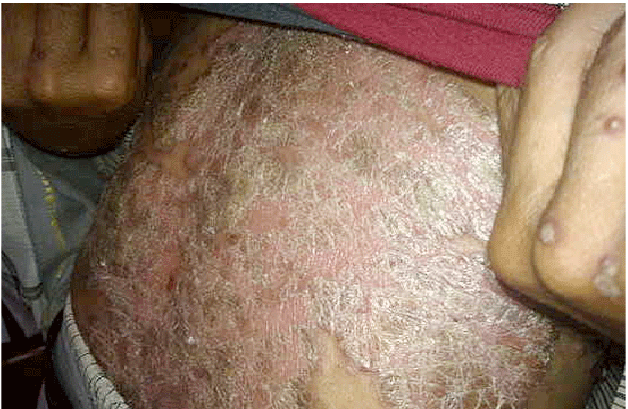
Fig 1: Generalized plaque